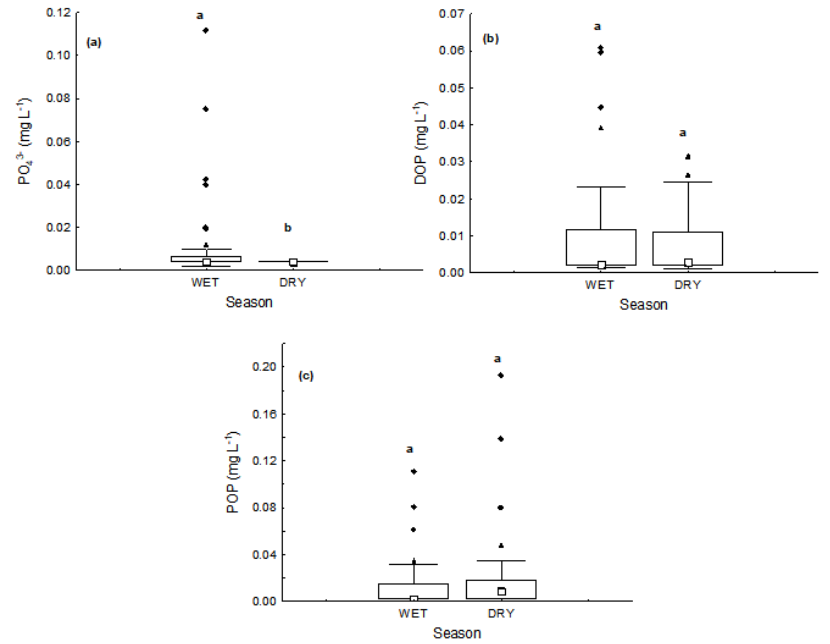
Figure 7. Box and whisker plots of seasonal variation of water quality variables: ( a ) PO 43 - , ( b ) DOP, ( c ) POP. Small white squares represent median values, boxes represent the interquartile range, range bars show the maximum and minimum values, black triangles represent the extremes and black diamonds show the outliers. Different letters (a and b) over box plots indicate a significant difference (Mann-Whitney U test, p < 0.05).